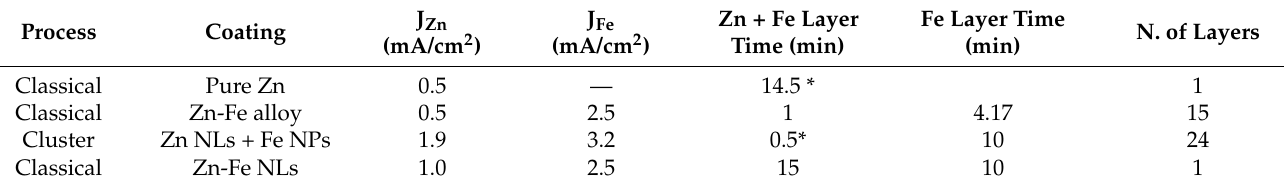
Table 1. Deposition parameters to produce the different coating